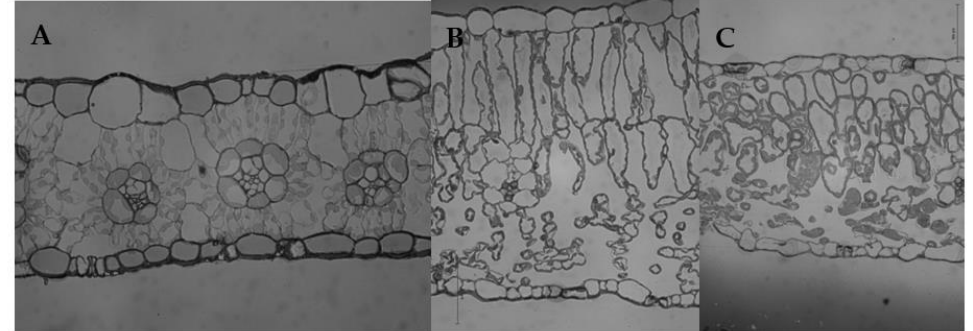
Figure 5. Effects of full sunlight and low light (10% full sunlight) on the CFI curves of the adaxial ( A – C ) and abaxial ( D – F ) sides of sunflower leaves. The intensities of pulsed light were 200 ( A , D ), 1000 ( B , E ), and 3000 ( C , F ) µmol·m −2 ·s −1 .